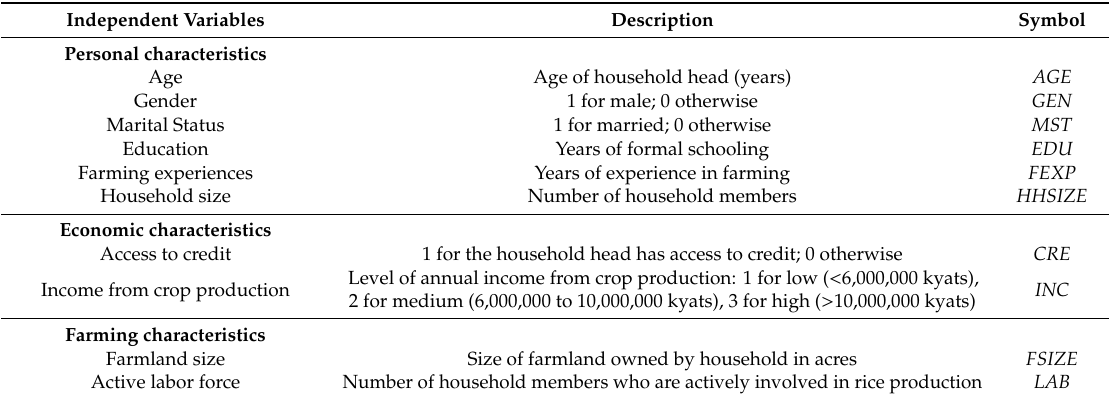
Table 2. Description of independent variables.